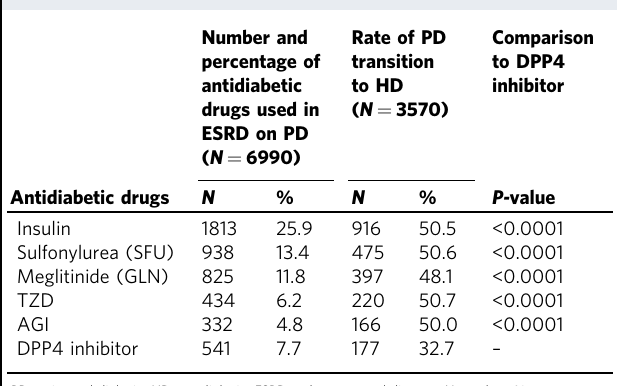
Thiazolidinediones (TZD): Pioglitazone, Rosiglitazone; Alpha-glucosidases inhibitor (AGI): Acarbose; Dipeptidyl peptidase-4 (DPP4) inhibitors: Linagliptin, Saxagliptin, Sitagliptin, Alogliptin,